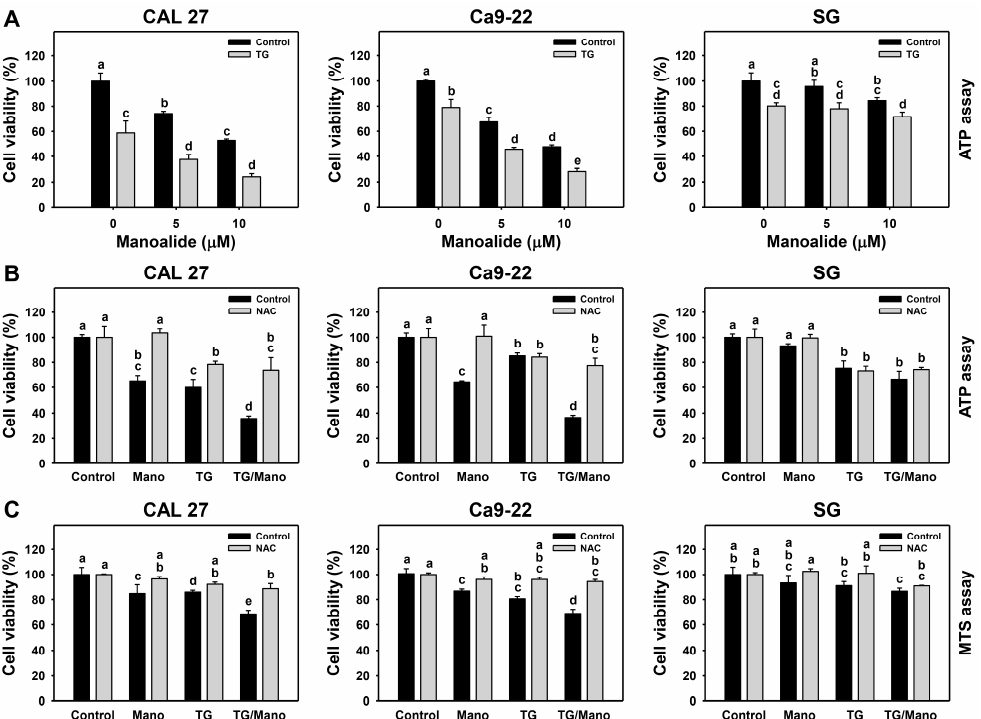
Figure 4. ER stress inducer (TG) enhances the antiproliferative effect of manoalide on oral cancer cells. ( A ) Cell viability of TG and/or manoalide was assessed by ATP assay. Cells were co-treated with TG (0.01 μ M) and manoalide (0, 5, and 10 μ M) for 24 h. ( B , C ) NAC effects on cell viability of TG and/or manoalide (Mano) were assessed by ATP and MTS assays. Following NAC (10 mM for 1 h), cells received TG and/or manoalide treatment (control, TG 0.01 μ M, and/or Mano 10 μ M) for 24 h. Data, means ± SDs ( n = 3). Multiple comparisons were analyzed for the same cell lines. Treatments marked with different notes indicate a significant difference ( p < 0.05 to 0.0001).